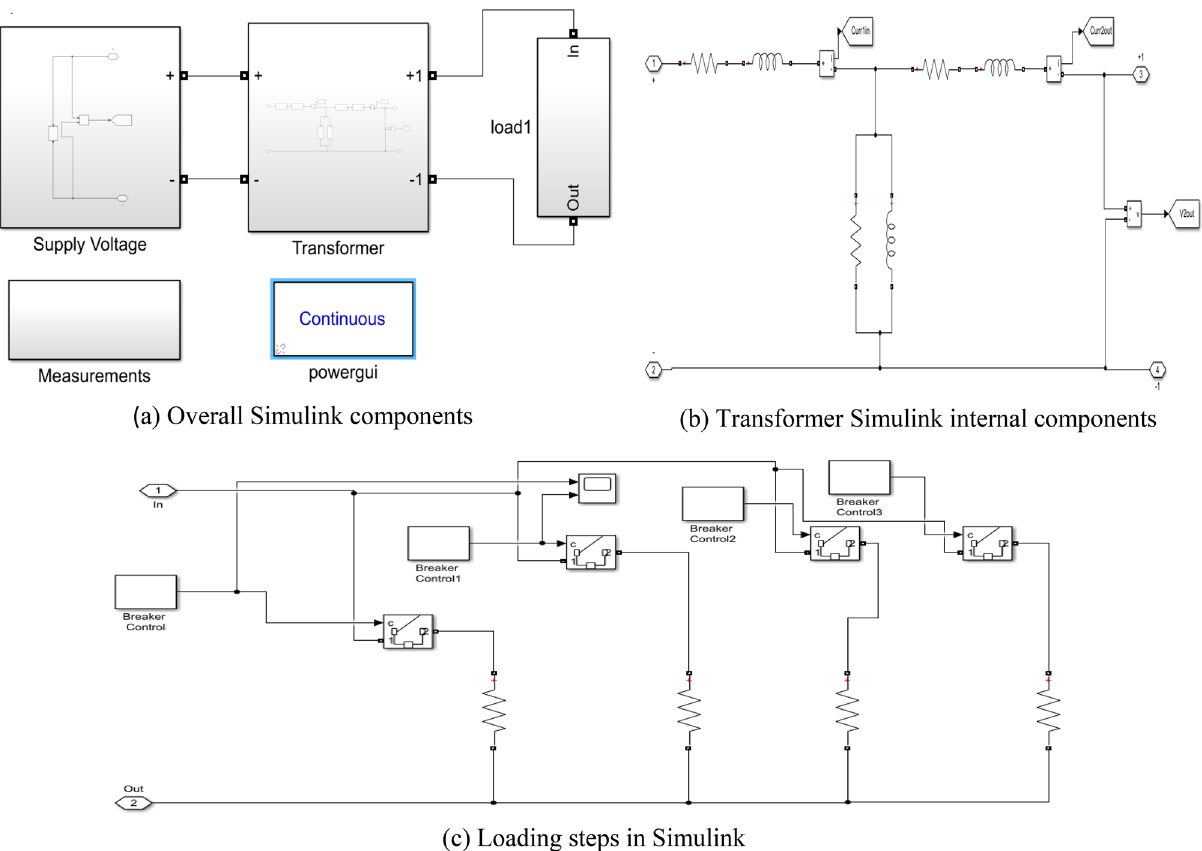
Figure 7. Transformer